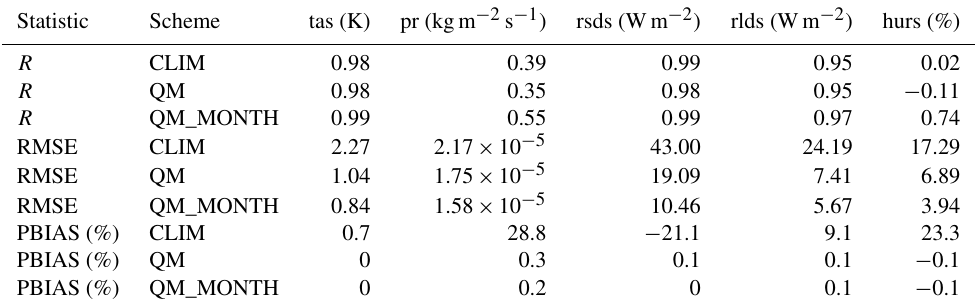
Table 3. Statistics from the evaluation shown in Fig. 3. Correlation ( R ), root mean squared error (RMSE), and percentage bias (PBIAS) are given relative to the downscaled ERA5 data T-MET.